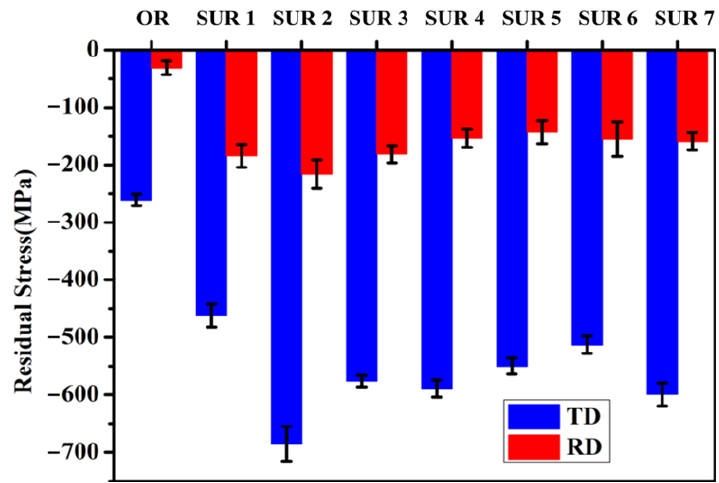
Figure 6. Surface residual stress changes of samples under different surface ultrasonic rolling treat- ments.